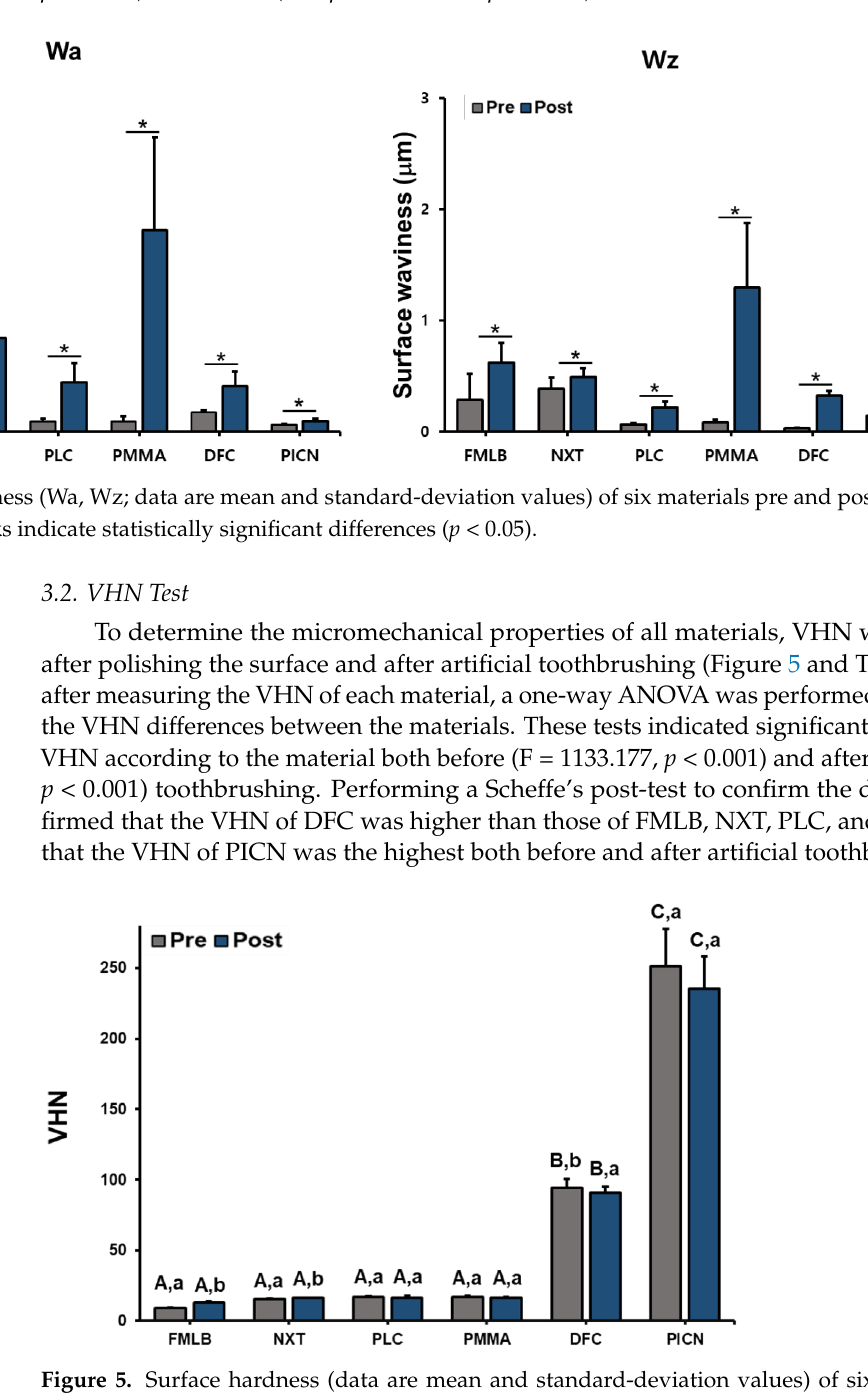
Figure 3. Surface roughness (Ra, Rz; data are mean and standard-deviation values) of six materials pre and post artificial toothbrushing. Asterisks indicate statistically significant differences ( p < 0.05).